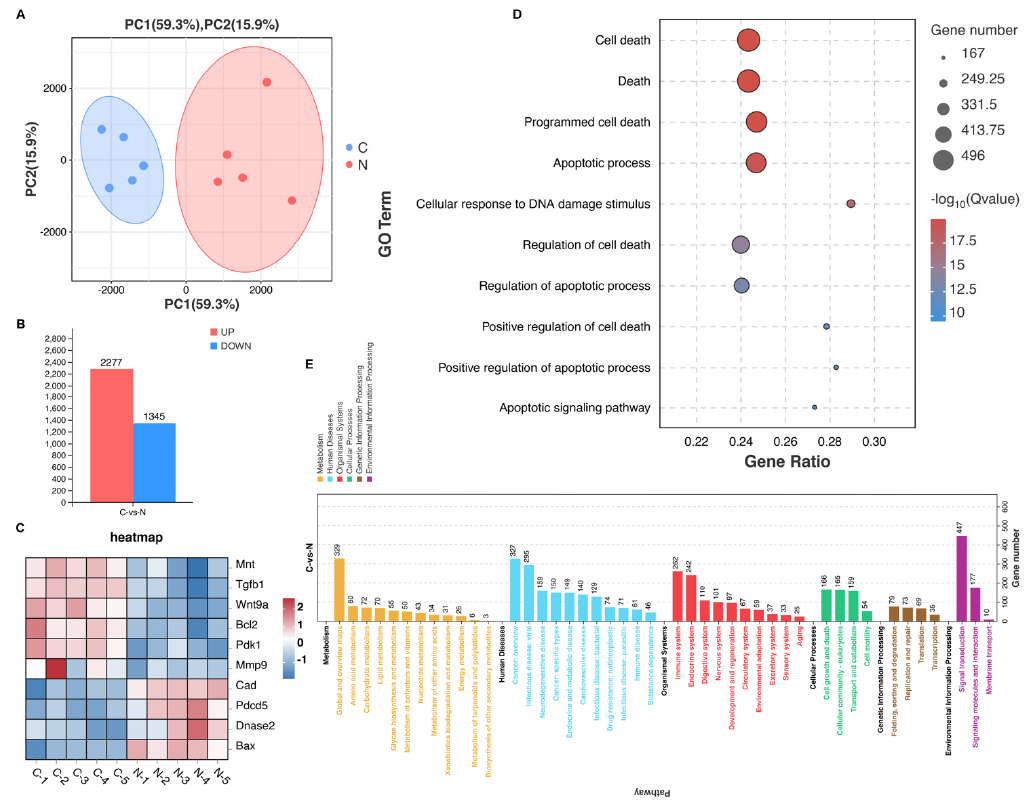
Figure 4. NsPEF promotes the activation of apoptosis-related pathways. ( A ) Principal component analysis (PCA) of the control group ( C ) and nsPEF group (N). ( B ) Statistical map of differential genes. ( C ) Differential expression heatmap of apoptosis-related genes. ( D ) Gene Ontology (GO) analysis associated with cell death. ( E ) Kyoto Encyclopedia of Genes and Genomes (KEGG) enrichment analysis.